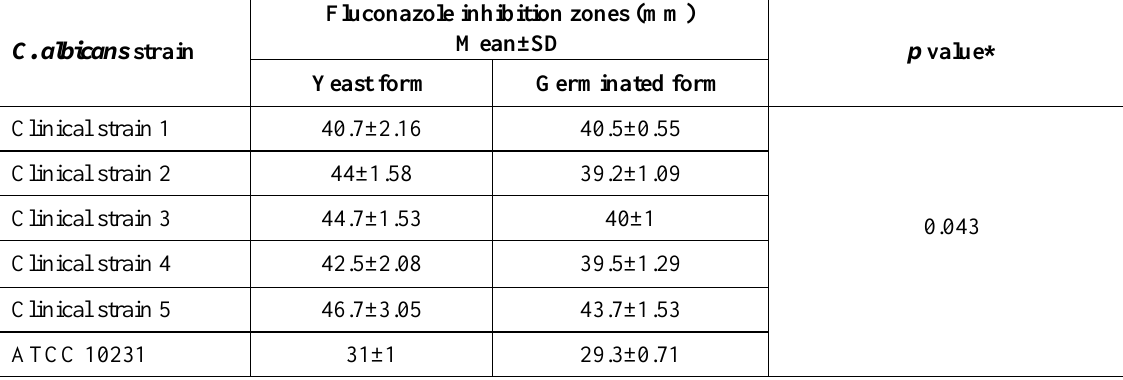
Table 2. Fluconazole inhibition zones (measured in mm) for yeast forms and germinated forms of tested Candida albicans strains obtained from disk diffusion